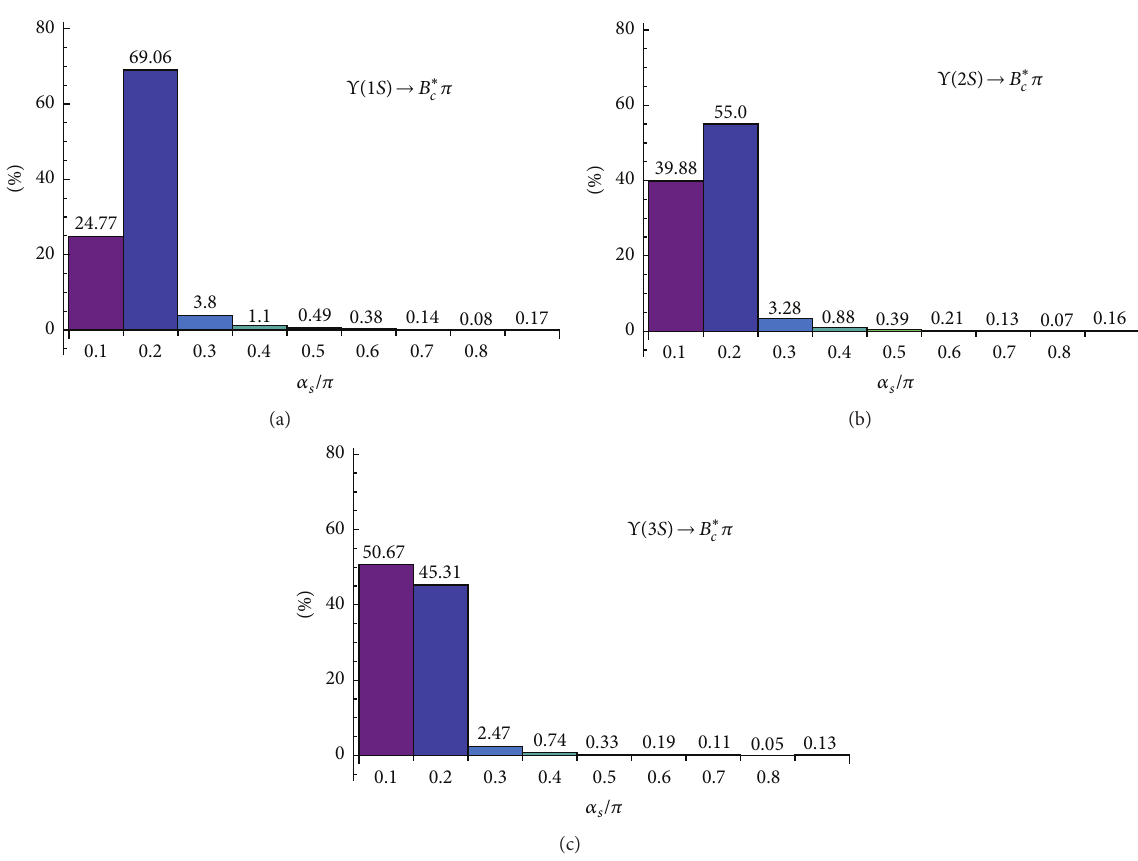
Figure 3: The contributions to branching ratios for Υ(1𝑆) → 𝐵 ∗ 𝑐 𝜋 decay (a), Υ(2𝑆) → 𝐵 ∗ 𝑐 𝜋 decay (b), and Υ(3𝑆) → 𝐵 ∗ 𝑐 𝜋 decay (c) from different region of 𝛼 𝑠 /𝜋 (horizontal axes), where the numbers over histogram denote the percentage of the corresponding contributions.